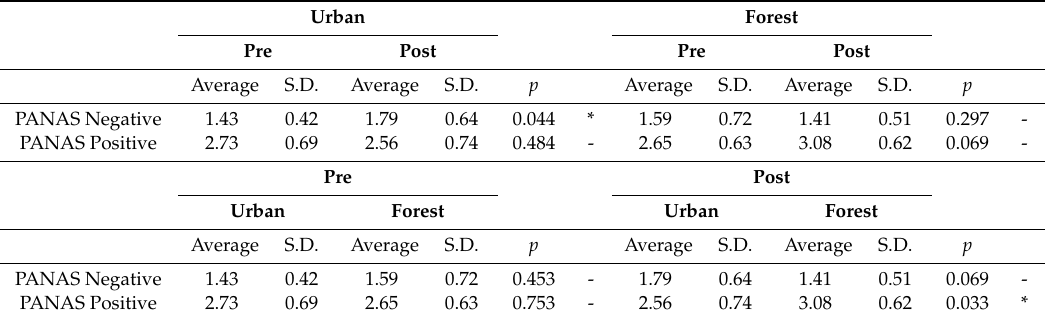
Table 6. Results of multiple comparisons of PANAS scores for urban street versus forest environments, as well as before and after environmental exposure.